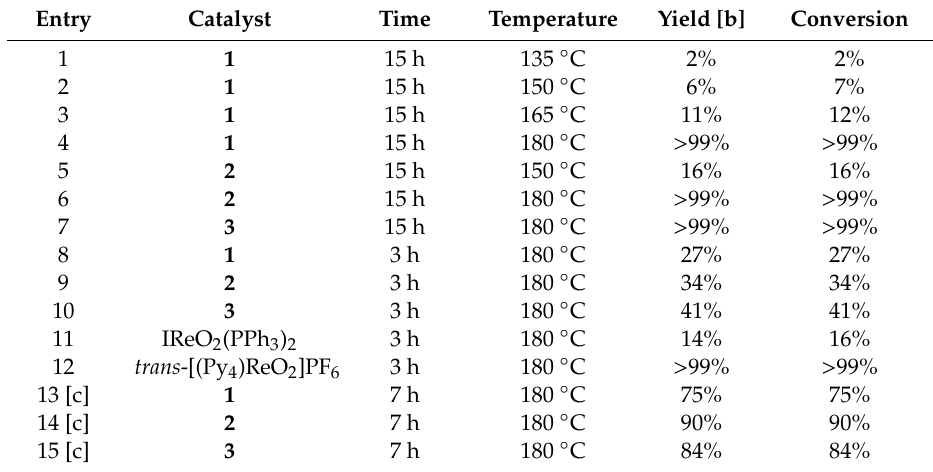
Table 3. Deoxydehydration of 1,2-octanediol catalyzed by dioxo-rhenium complexes.